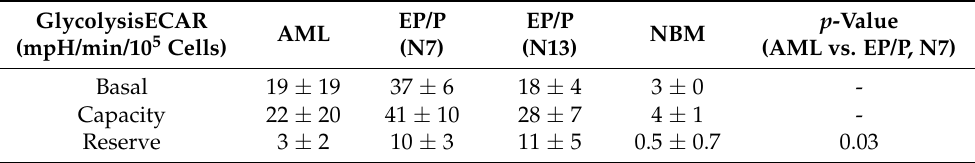
Figure 1. Metabolic characterization of primary AML blasts and early progenitors/precursors (EP/Ps) from cultured normal cord blood CD34+ cells. Metabolic characterization of primary blasts from AML patients, EP/P at day 7 (N7, mostly a promyelocyte population) and at day 13 (N13, mostly granulocytes) and in normal bone marrow (NBM). ( a ) Profile of the glycolytic activity. Histograms represent basal glycolysis, glycolytic reserve and glycolytic capacity measured using the XF Glycolytic Rate Assay. ( b ) Profile of the mitochondrial activity. Histograms represent basal respiration, spare respiratory capacity and mitochondrial ATP production measured using the XF Myto Stress Test Assay. Data are presented as mean ± SD. Statistical analyses were performed using the ANOVA, t -test and Tukey’s Multiple Comparison Test; * p ≤ 0.05. Table 2. Glycolysis values in AML blasts and normal hematopoietic